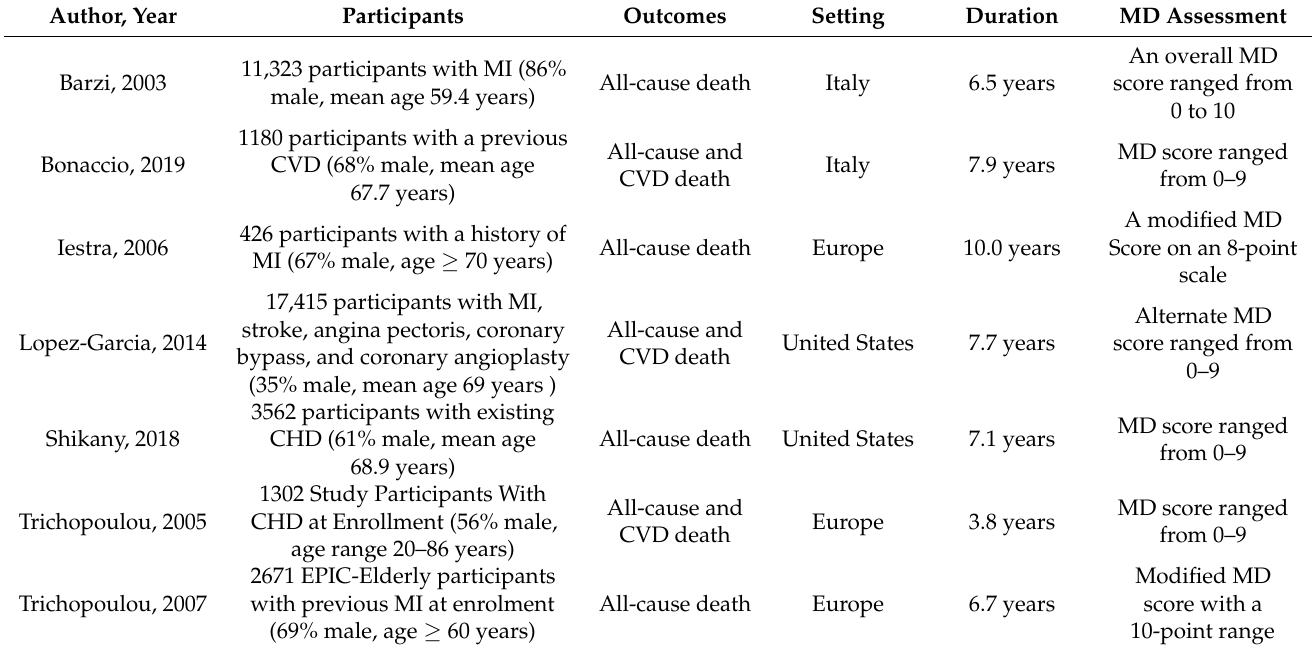
Table 1. Characteristics of included prospective cohort studies.